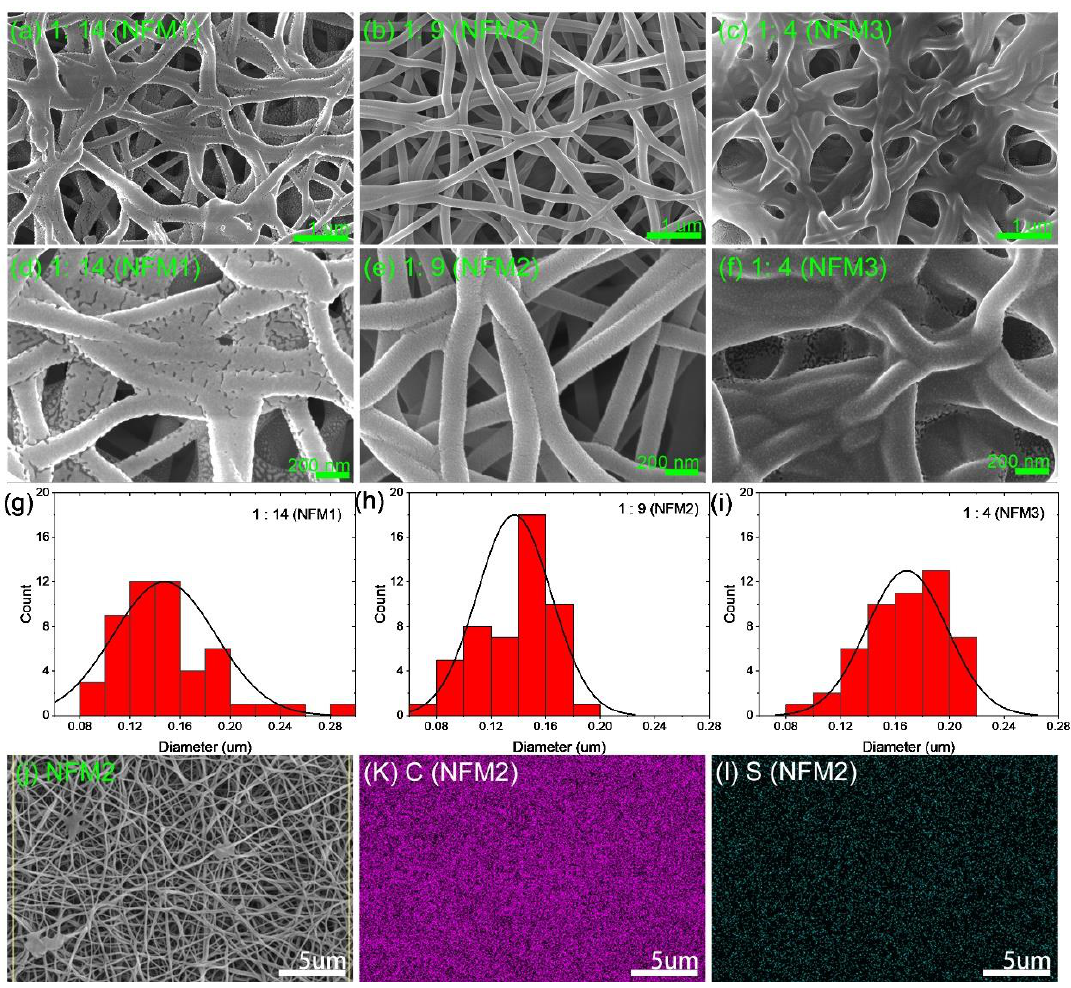
Figure 2. Scanning electron microscopy (SEM) images of the poly-1,8-naphthimide derivative-zwitterionic/poly(vinyl alcohol) (PNI-SBMA/PVA) NFMs and diameter distribution at different ratios: 1:14 ( a , d , g ), 1:9 ( b , e , h ), and 1:4 ( c , f , i ). ( j ) SEM image of NFM2 with the EDS mapping spectrum of the ( k ) C and ( l ) S element.